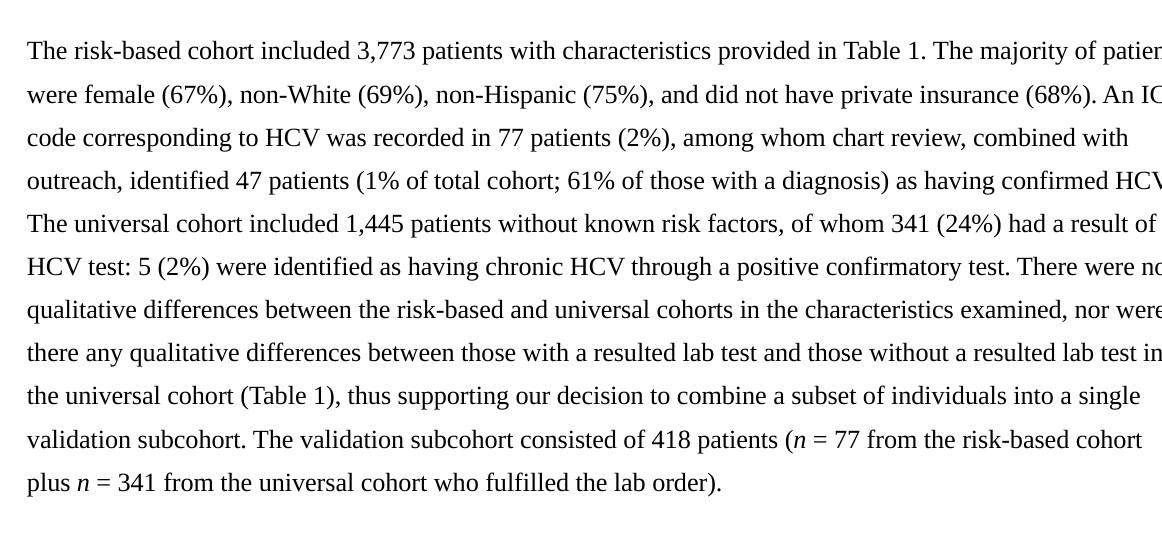
Figure 2 . Study enrollment and decision steps to classify an individual’s chronic hepatitis C virus infection status from the electronic health record among patients seen at an urban federally qualified health center. ‘ X ’ denotes a patient’s true infection status, while ‘ W ’ denotes a (potentially incorrect) diagnostic code in the electronic health record. Gray shaded box depicts the validation subcohort ( n = 418). HCV = chronic hepatitis C virus infection; HER = electronic health record. † Dashed lines indicate missing HCV status for patients without laboratory testing in risk- based